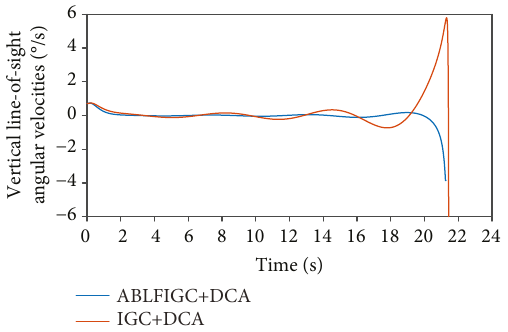
Figure 11: Sideslip angle curves of the interceptor missile in Scenario 2: ABLFIGC+DCA refers to a combination of the proposed asymmetric barrier Lyapunov function-based IGC algorithm and the dynamic control allocation algorithm; IGC+ DCA refers to a combination of the IGC algorithm subject to the traditional dynamic surface sliding-mode control law and the dynamic control allocation algorithm.